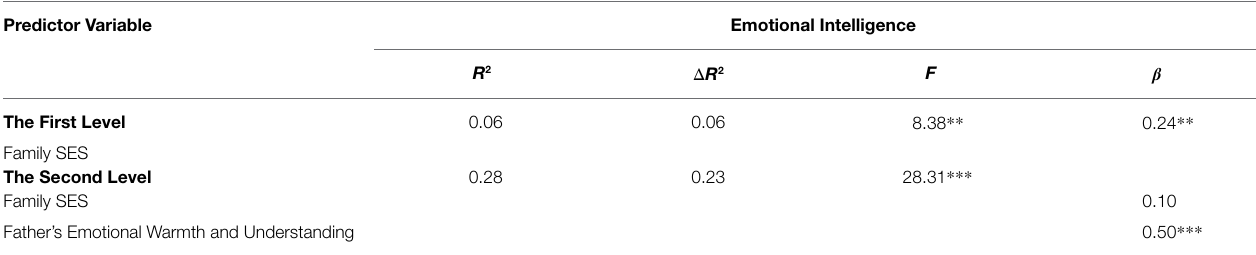
TABLE 6 | Regression analysis of Shanghai primary school students’ emotional intelligence on family socioeconomic status, father’s emotional warmth and